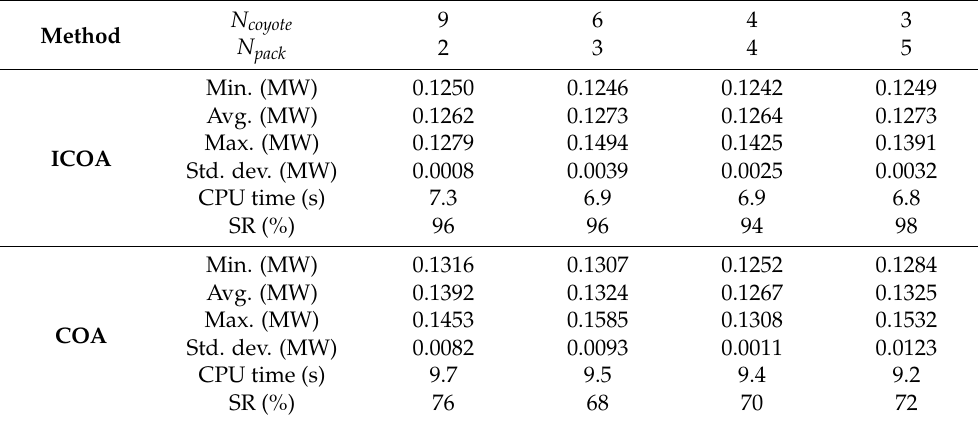
Table 4. Results found by the proposed ICOA approach for L index objective of the IEEE 30-bus system.